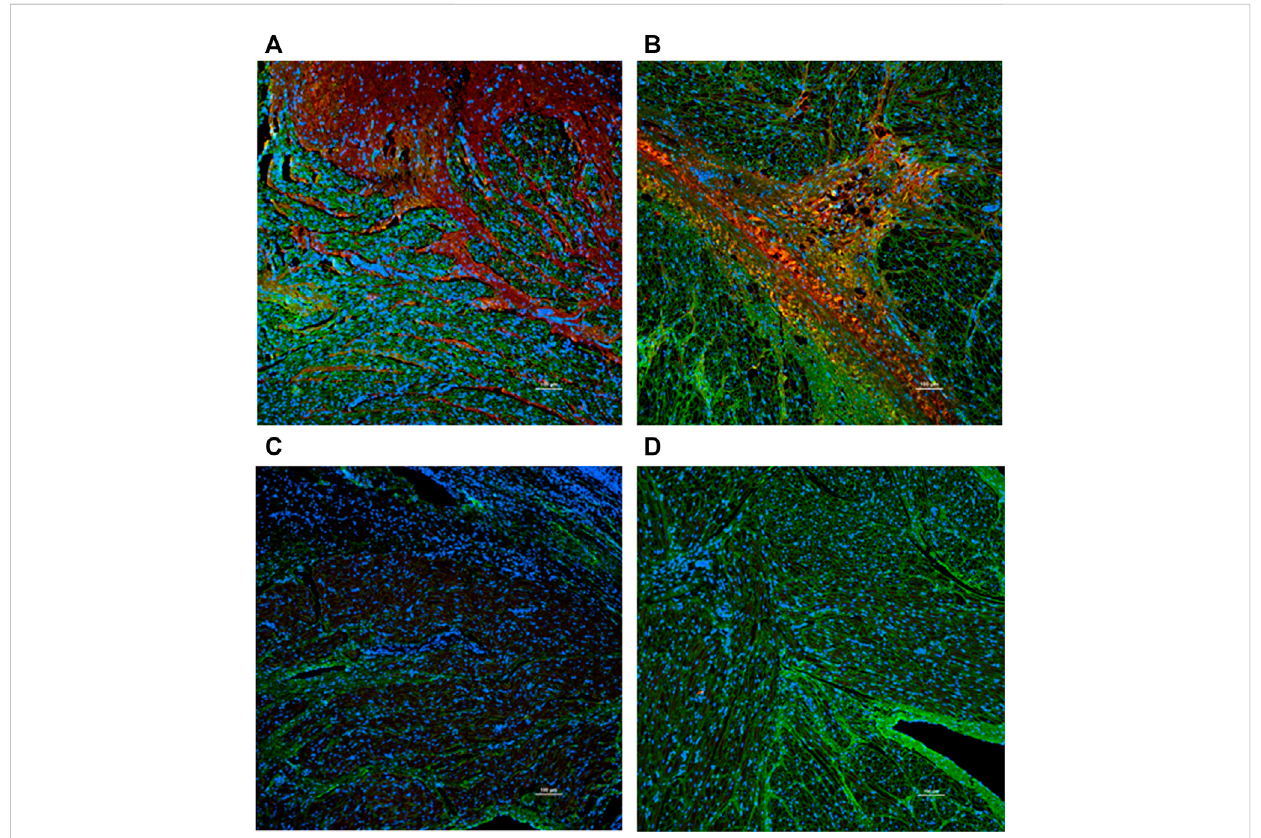
FIGURE 5 Immuno fl uorescence staining (×10 objective). Green: Wheat Germ Agglutinin; Blue: Nuclear. Red: Anti-bodies. (A) Anti- fi bronectin. (B) Anti- collagen (I) (C) Anti-macrophage. (D) Anti-caspase 3. The anti- fi bronectin and anti-collagen I were positive (red stain was evident), while the anti- macrophage and anti-caspase were negative (red stain was not